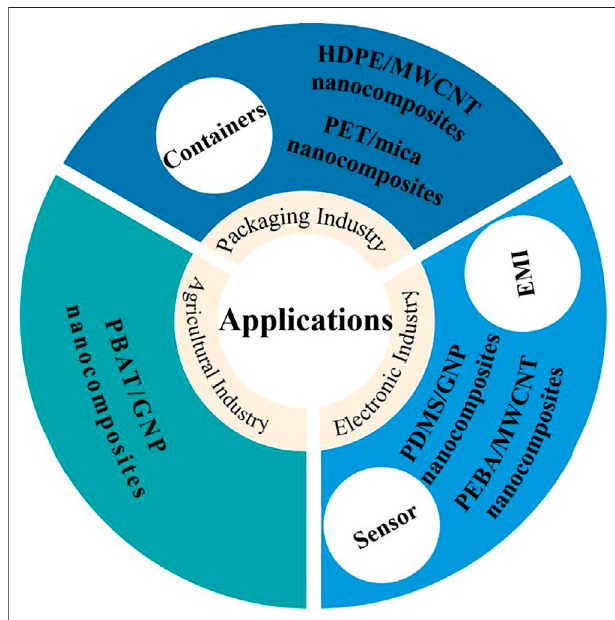
FIGURE 3 | Applications of biaxially stretched